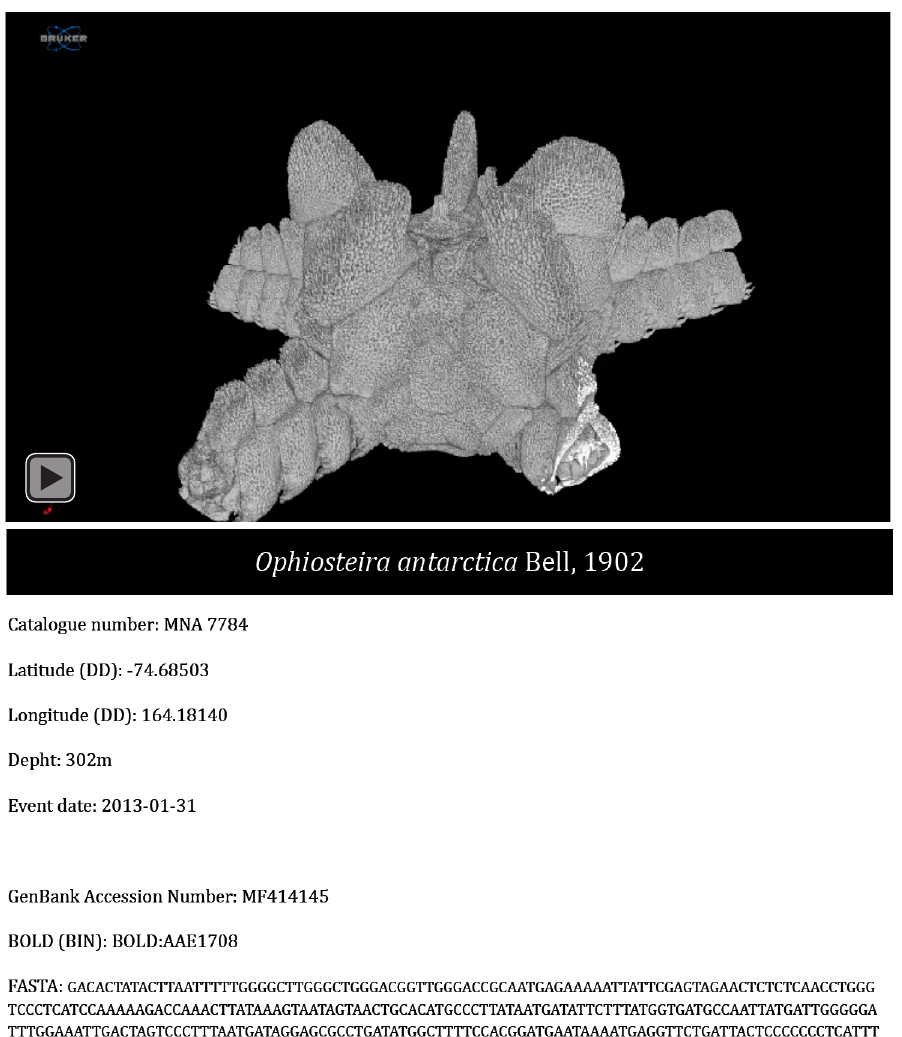
Figure 8. Video of the 3D model of O. antarctica (MNA 7784); Catalogue number, latitude (DD), longi- tude (DD), depth and event date as described in the section “Dataset description”; GenBank Accession num- ber, the Barcode Index Number from the Bold system and the complete COI sequence in FASTA format.